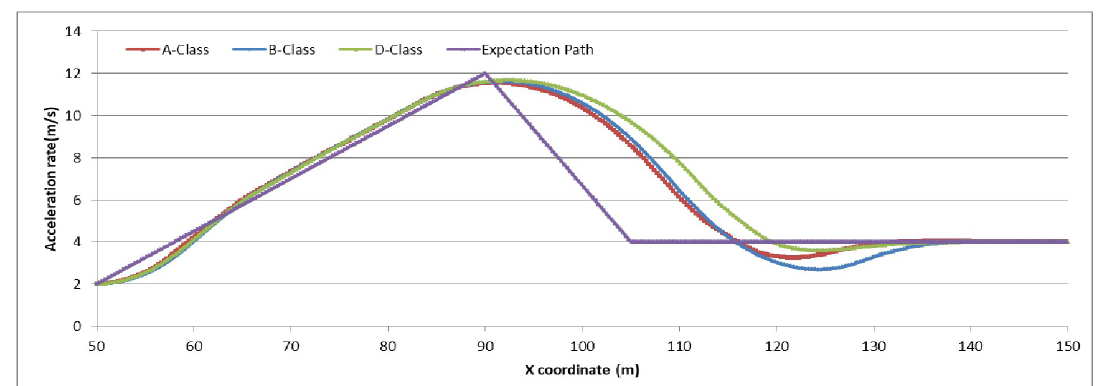
Fig 8. The vehicle driving trajectory of different vehicle models in N E = 10 (Group 2).